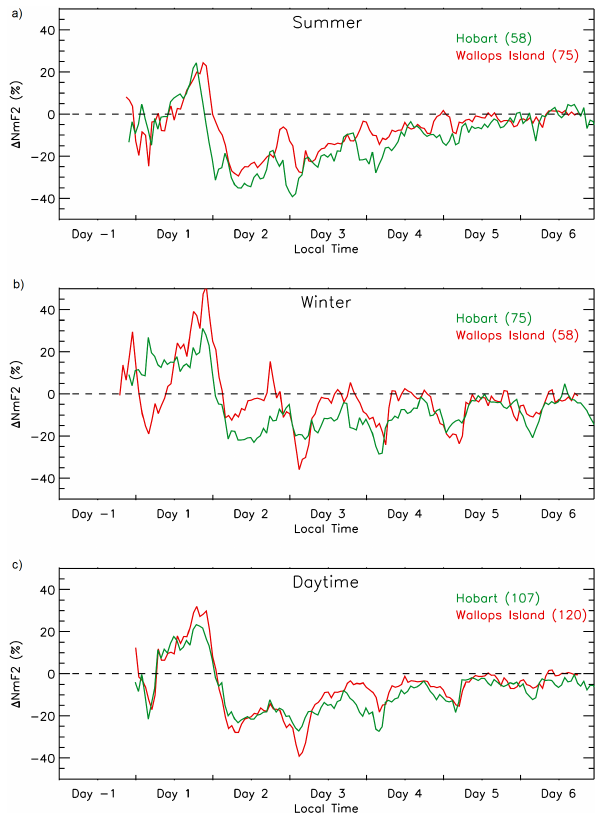
Fig. 7. Average storm patterns of Nm F2 (%) in local time for sub- sets of the 206 storms portrayed in Fig. 5, selected to have different storms in each sample by station. Panel (a) gives results for storms that occurred during local summer months (the four months span- ning the June solstice at Wallops Island and the four months span- ning the December solstice at Hobart). Panel (b) gives the results for storms in local winter months (i.e., the reverse set of panel a). In panel (c) , the average storm patterns are shown for storms that occur during daytime (07:00–18:00LT) hours at both stations and lead to regular-positive-phase (RPP) events. Given the 15h differ- ence in local time between Wallops Island and Hobart, most of the storms are not the same at both